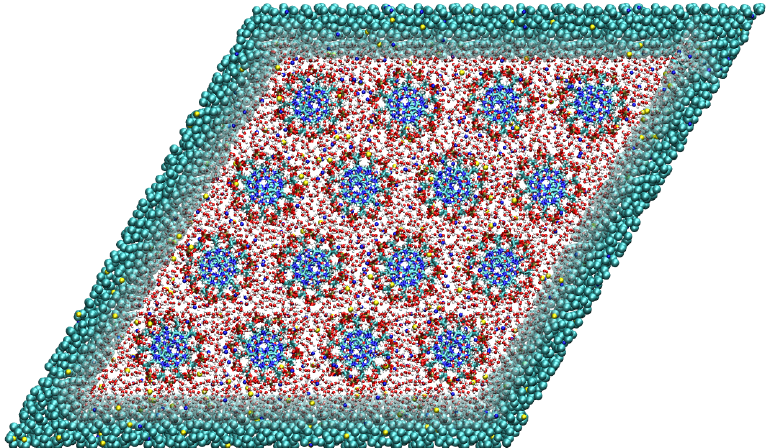
Figure 3. Top-down view on the simulation box containing 16 DNA molecules arranged on a hexagonal lattice. The DNA molecules are at all times modeled with the high atomistic resolution. For the solvent, we use two levels of resolution, i.e., the atomistic resolution in the rhombic region containing the DNA molecules and the coarse-grained representation outside. Adapted from Ref.